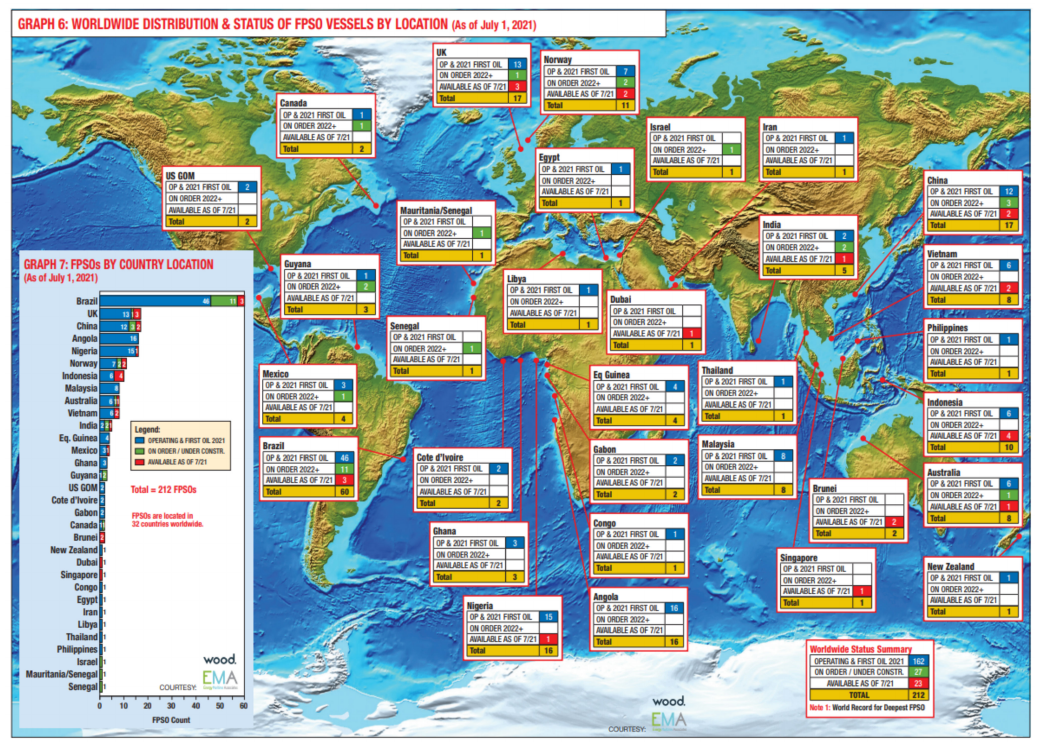
Figure A4. Worldwide distribution and location of floating production, storage and offloading (FPSO) vessels (Courtesy: Offshore magazine, Wood & EMA.).